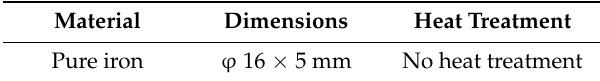
Table 2. Sample parameters.